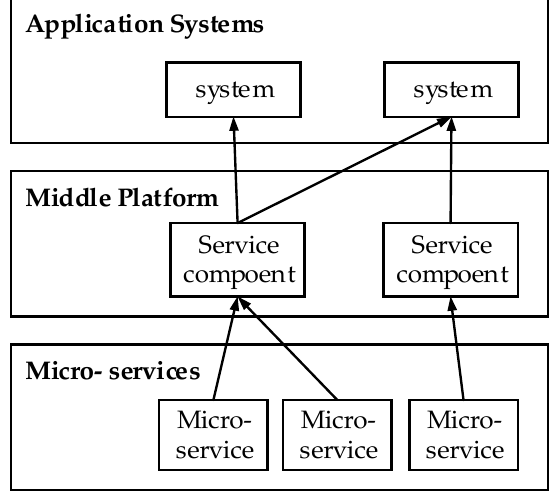
Figure 1. Middle platform architecture based on micro-service.